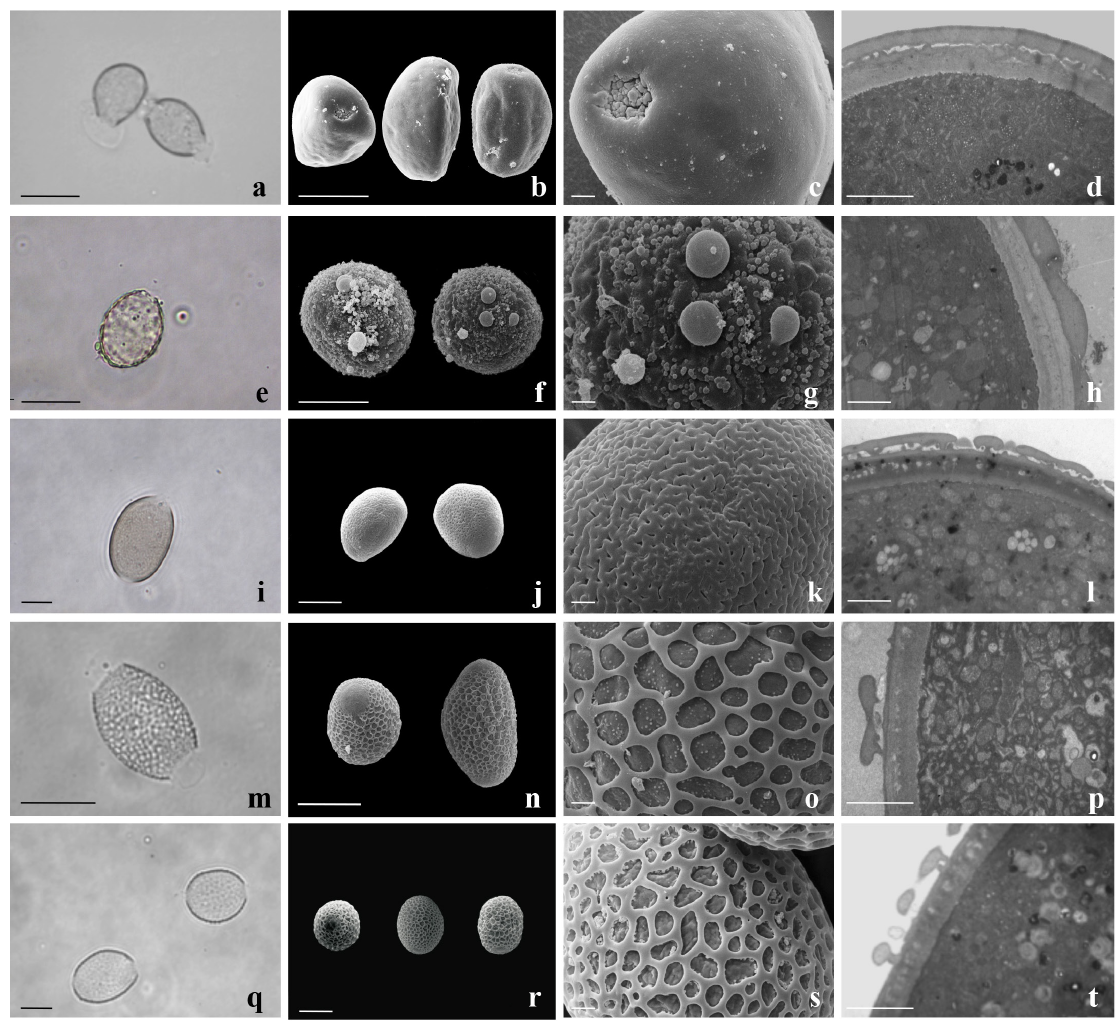
verrucate (Figure 1e-h). Ae. distichantha : medium pollen, bilateral symmetry, oblate shape, diporate, exine, rugulate with perforations (Figure 1i-l).